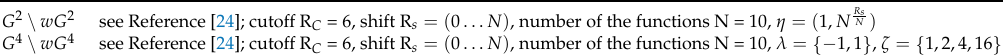
Table A3. Detailed description of the elemental features used in ML scheme for the dataset II and constituting the part of the dataset